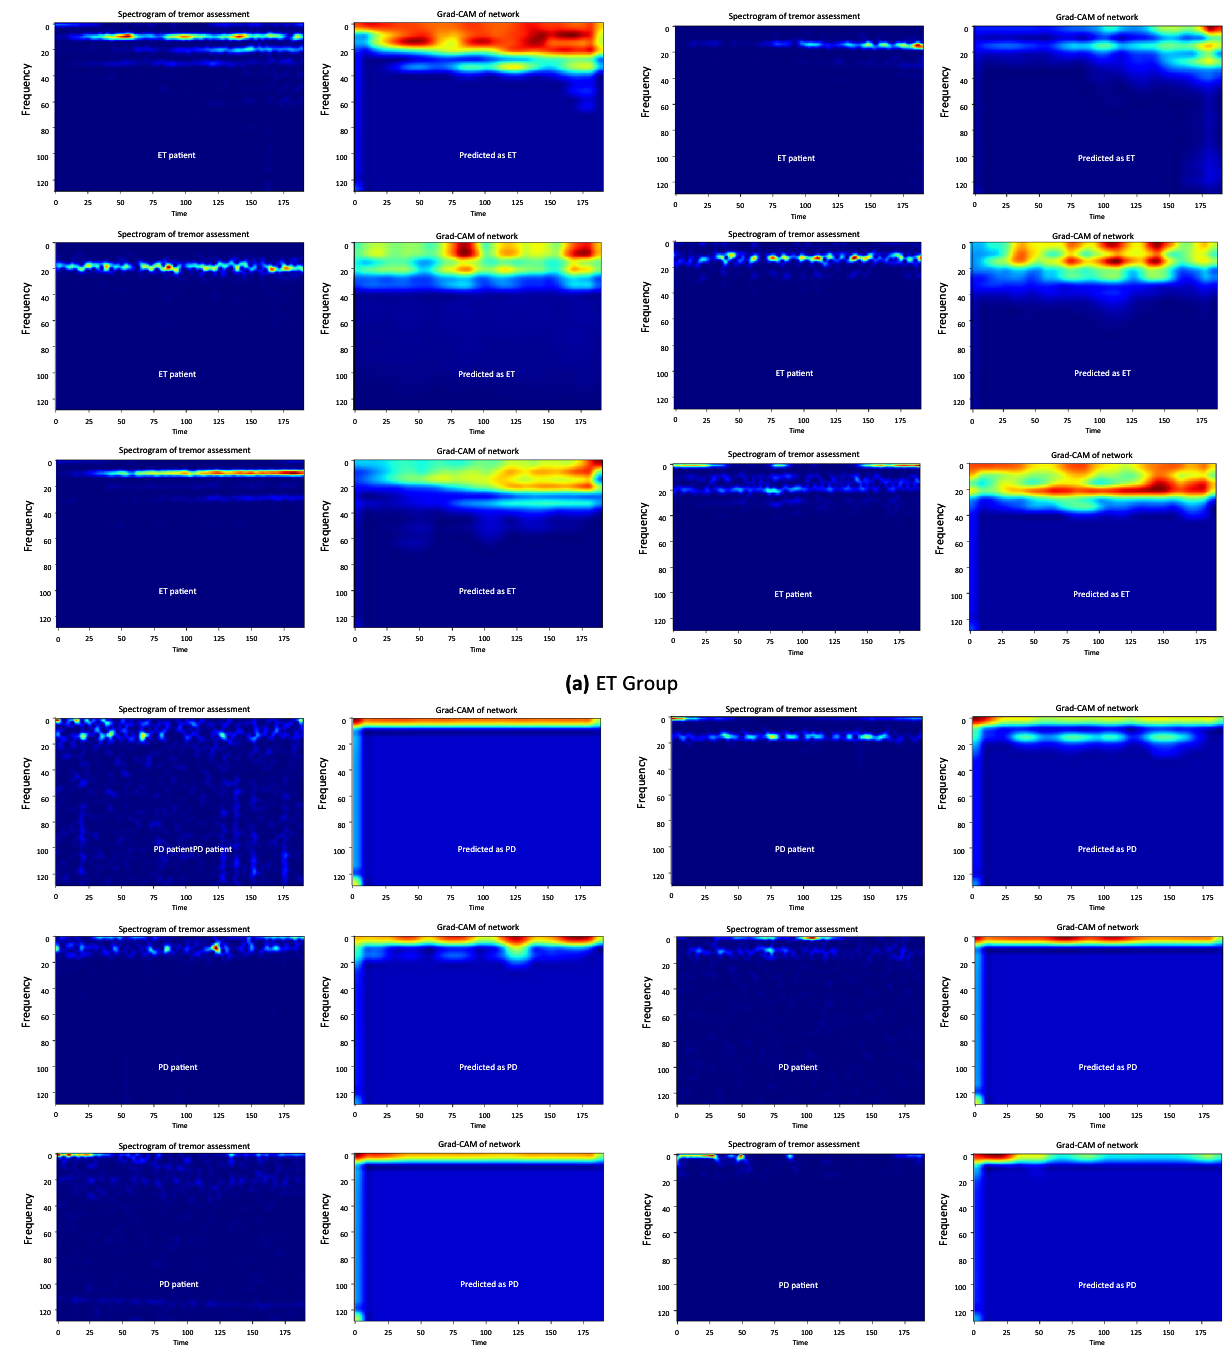
Figure 6. Analysis of explainability for NeurDNet . It should be highlighted to convert the values y-axis scale to frequency in Hz, the values need to be multiplied by